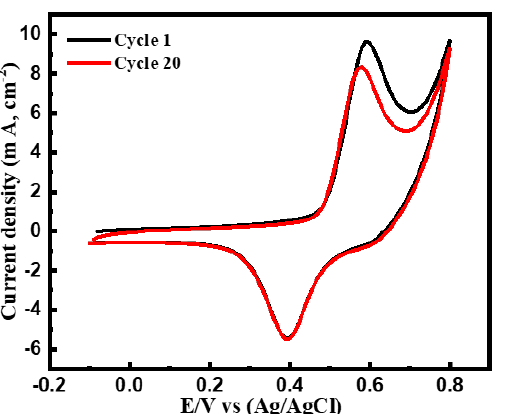
Figure 7. Cyclic voltammetric response of CuNi-MC electrode in 1 mM glucose solution at the first cycle and after 20 cycles at a scan rate of 50 mV s − 1 .